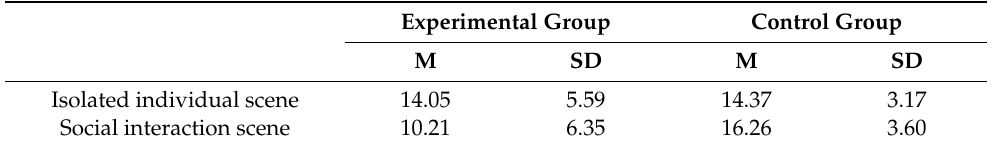
Table 1. Overall fixation counts of experimental group (autistic children) and control group (TD children) in different